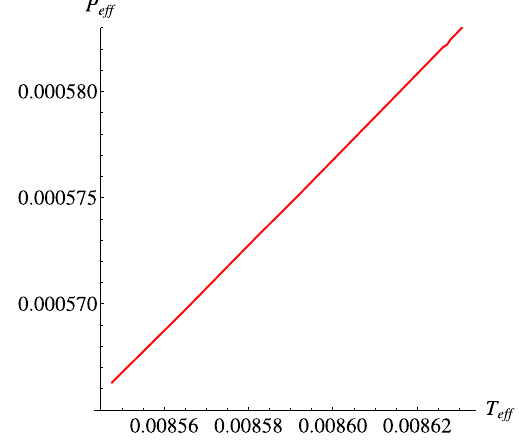
Fig. 8 The equal-area law in the phase diagrams of P ef f − V and T ef f − S